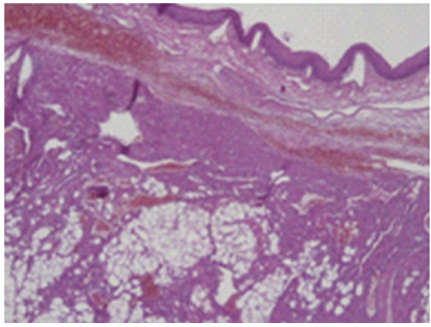
Figure 2: The tumour is composed of adipose tissues, smooth muscles, and vessels (Hematoxylin and eosin; magnification × 40).